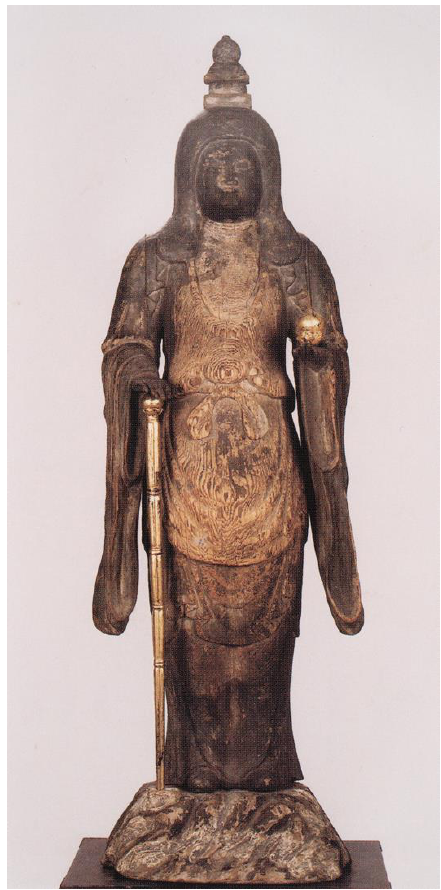
Figure 2. Uhō Dōji , Heian Period, Cypress wood, 102 cm. Kongōshōji, Ise City. Reproduced with Figure 2. Uh¯o D¯oji , Heian Period, Cypress wood, 102 cm. Kong¯osh¯oji, Ise City. Reproduced